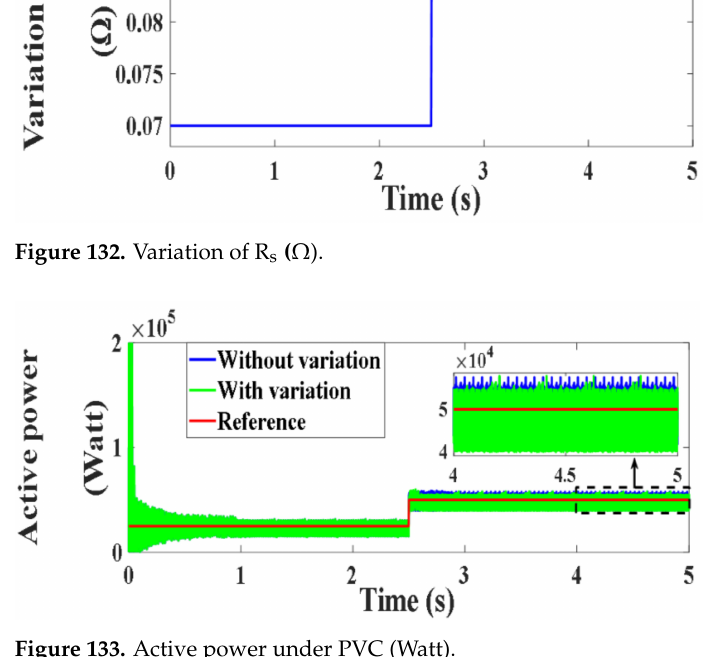
Figure 133. Active power under PVC (Watt).